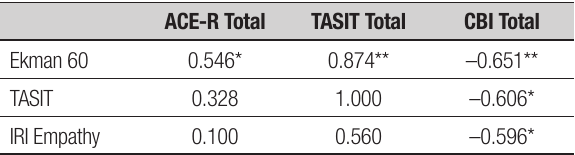
Figure 3. Caregiver ratings of interpersonal changes on the Interpersonal Reactivity Interview (IRI) in left and right SD cases. IRI data available for 11 left SD and 9 right SD cases. Error bars depict standard error of the mean. *p<0.05. Table 3. Spearman rank correlations showing relationships between experi- mental measures in the combined SD groups